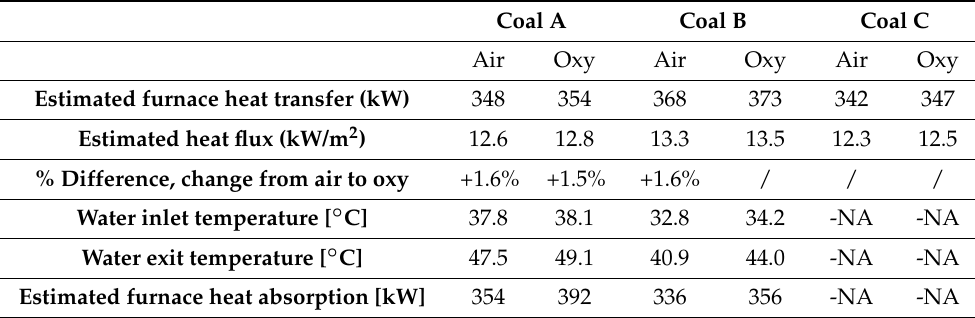
Table 1. Thermal inputs used in the study of Wall et al. Adapted with permission from Ref. [25] Copyright © 2009 The Institution of Chemical